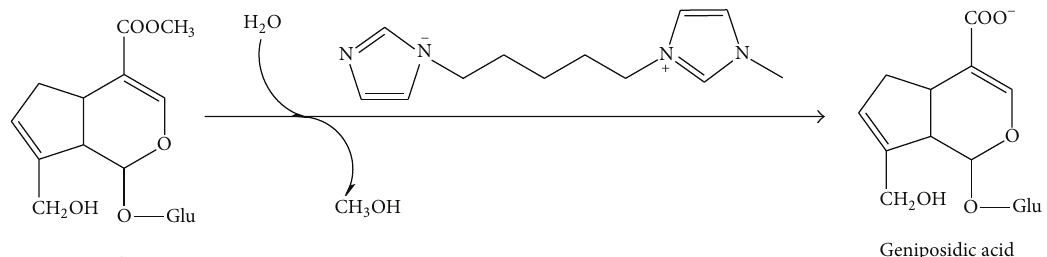
Figure 1: Hydrolysis mechanism of geniposide to form geniposidic